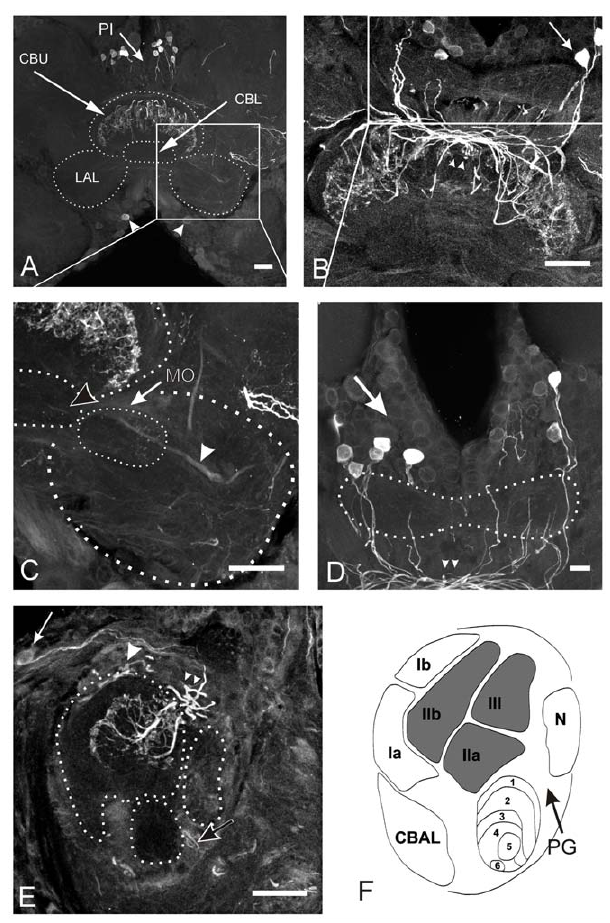
Figure 4. Citrulline immunoreactivity in the central complex. A–D: Frontal sections through the midbrain and central complex. E: Sagittal section through the central complex. Groups of citrulline immunoreactive cell bodies are located in the pars intecerebralis (PI, white arrows in A, B, D and E) and in the inferior median protocerebrum (arrowheads in A). Citrulline immunoreactivity is restricted to the layers II and III of the upper division (CBU) of the central body, while layer I and the entire lower division (CBL) was completely free of immuno- staining. Two types of immunoreactive neurons were distinguished. Pontine neurons contributing to intensive labeling in the posterior chiasm (small arrowheads in B, D and E) and additional faint labeling in tracts entering the CB through the dorsal and posterior face (large arrowhead in E). Immunostaining in the posterior groove (black arrow in E) resulted from tangential neurons. The lateral accessory lobes (LAL) contained weak staining. Citrulline-ir was detected in the median olive (MO in C) and the ventral shell (white arrowhead in C) of the LAL. F: Schematic drawing of a sagittal section through the CB (modified from [18,21]. Regions highlighted in gray contain citrulline positive fibers. CBAL=anterior lip of the central body, N=noduli. Scale bars=50 m m in A, B and C; 20 m m in D and